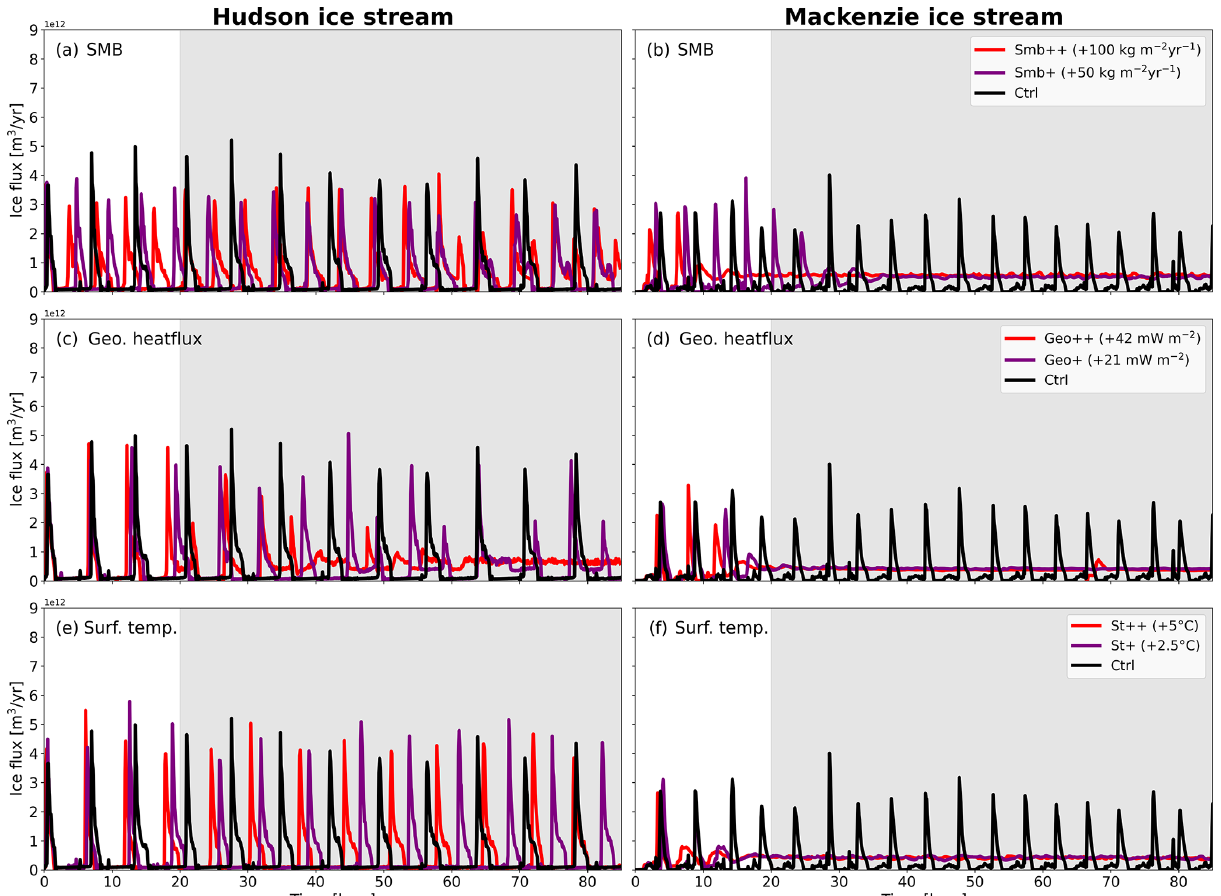
Figure B1. Similar to Fig. 7 but only showing the positive perturbation experiments wherein additional intermediate scenario simulations were performed. The panels show the response to (a, b) SMB, (c, d) geothermal heat flux, and (e, f) ice surface temperature. Grey shading highlights the analysis